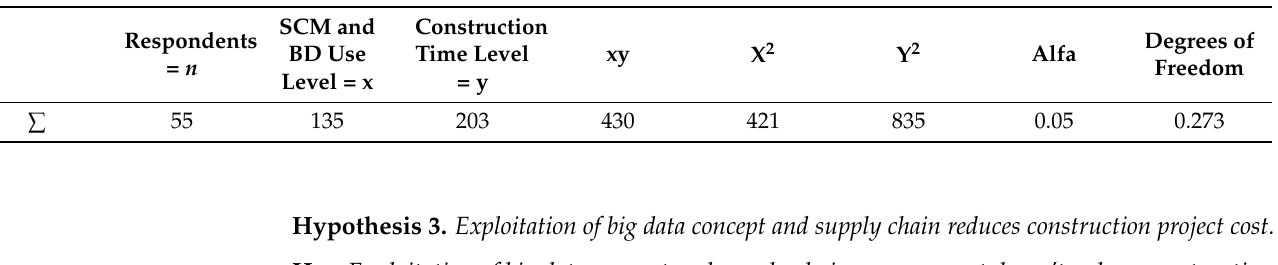
Table 4. Pearson correlation (SCM and BD use level and constriction time level). Table 5. Results of hypothesis: Big data concept in supply chain management shortens construction